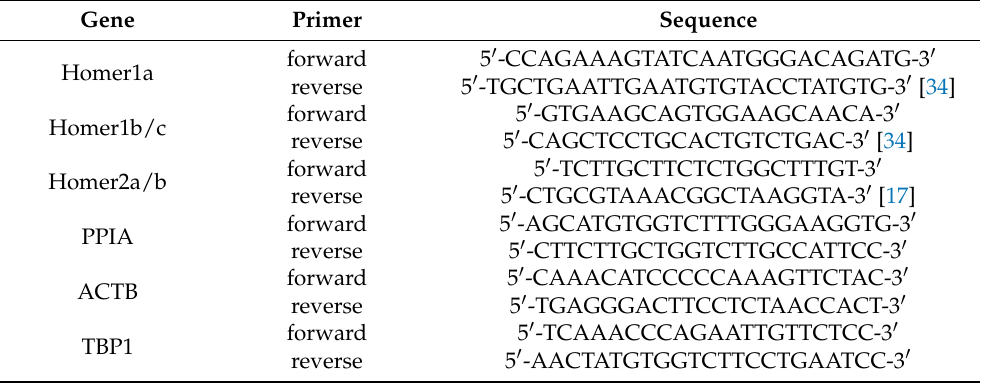
Table 2. Primer Sequences for Rat Tissue qPCR